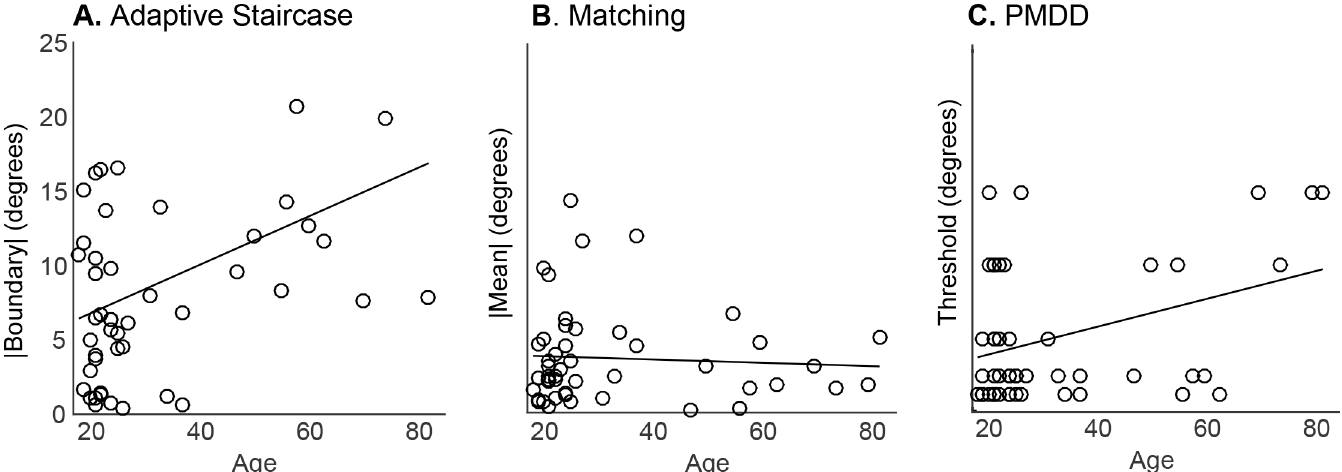
Fig 6. Group data on construct validity, with regression lines (N = 48). A. Perceptual boundary (absolute value) as measured with the adaptive staircase method showed a positive relationship with subject age, with older subjects having larger proprioceptive biases. B. Mean matching estimate (absolute value) is not predicted by subject age. C. PMDD threshold was also positively predicted by subject age, with older subjects tending to have higher